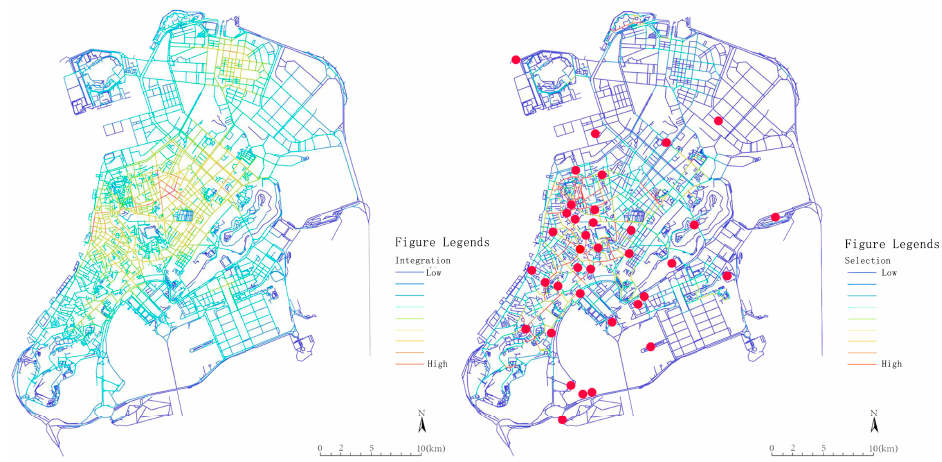
Figure 9. The local degree of integration and the degree of choice in the Macau Peninsula.